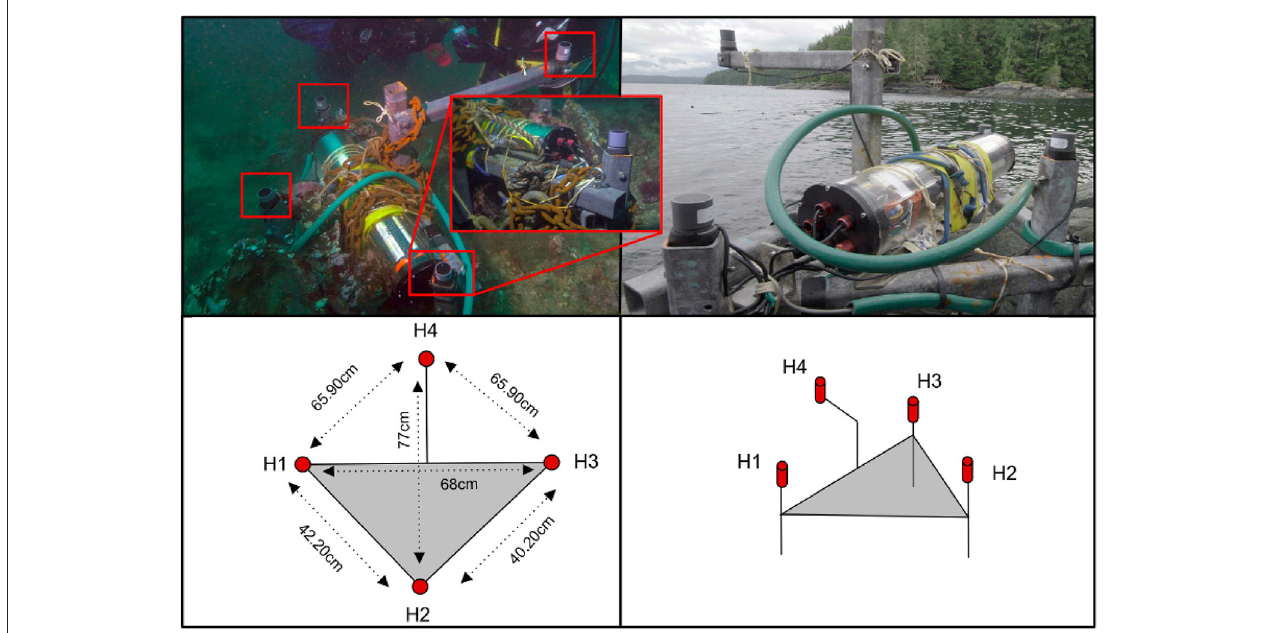
FIGURE 1 | (Top) The four-hydrophone antenna, with the 12 V (green) cable connected into Orcalab. (Bottom) Diagram of the antenna and its inter-hydrophone distances.